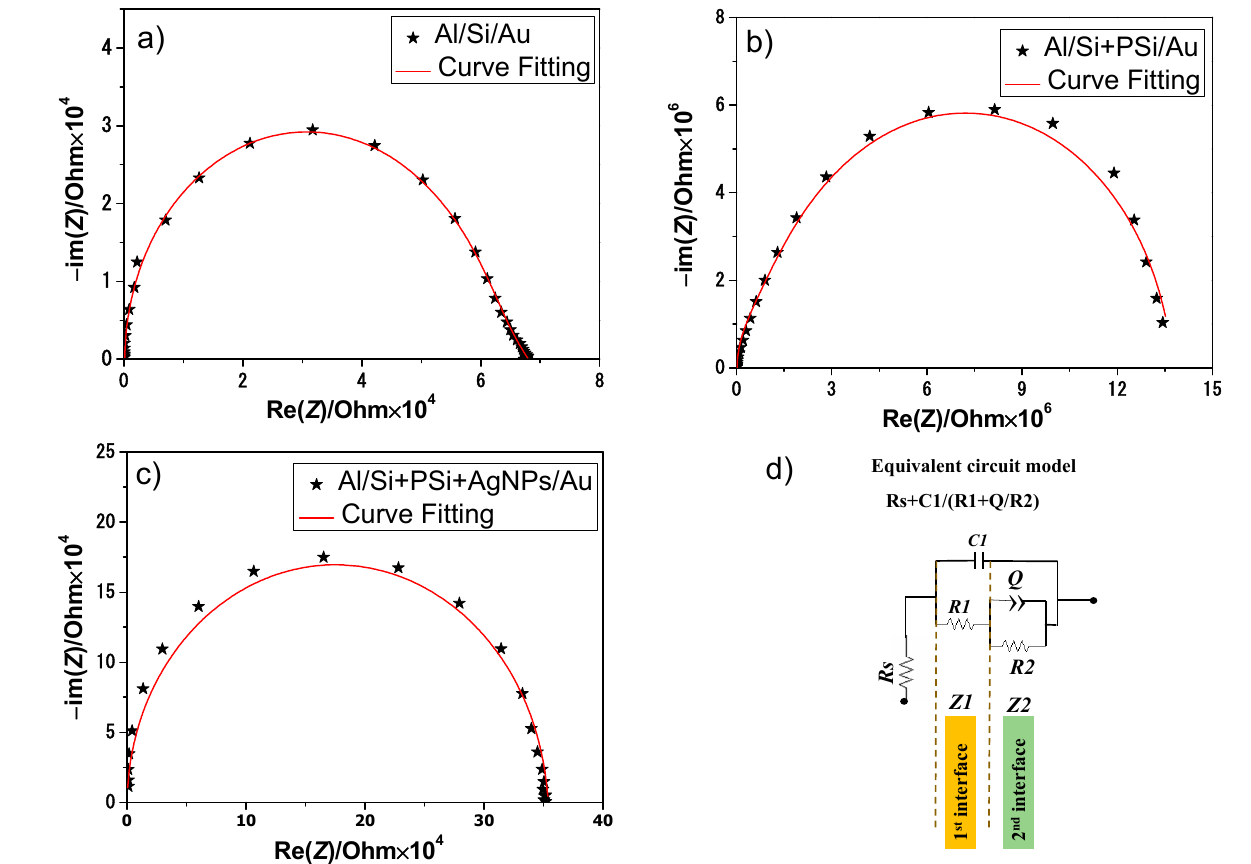
Figure 7. Nyquist plots for the performed Schottky diodes: ( a ) corresponds to Al/Si/Au diodes; ( b ) corresponds to Al/Si + PSi + AgNPs/Au diodes; ( c ) corresponds to Al/Si + PSi/Au diodes; ( d ) the favorable equivalent circuit model. Table 2. Comparison between the electrical parameters between the interfaces of the three Schottky diodes studied in this study.